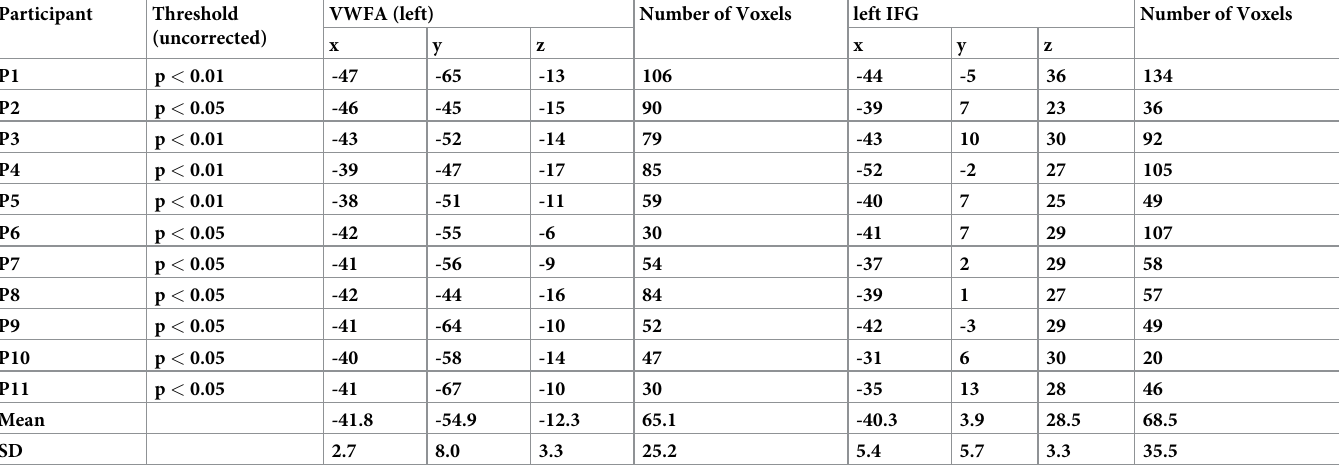
Table 2. Center Talairach coordinates and cluster sizes of individual ROIs for all